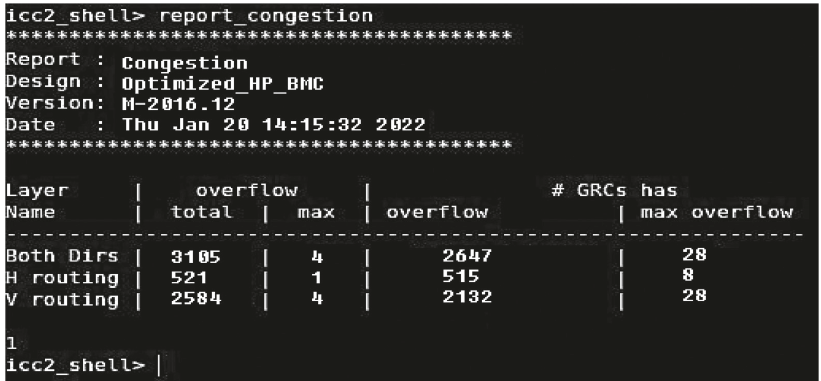
Figure 6: The postsimulation results, which show a significant reduction in the design and related simulation report congestion.